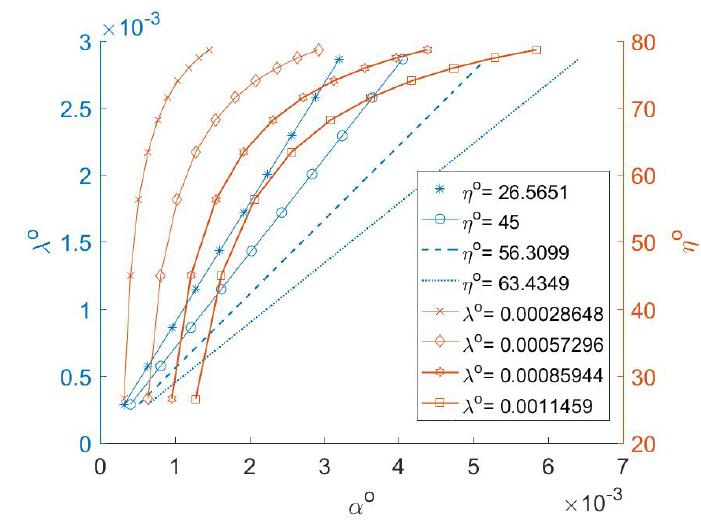
Figure 4. The relation between α and each of λ (the left vertical axis) and η (the right vertical axis). These results are obtained by changing the angles λ and η and the corresponding change in α is computed at a single sampling time of one of the simulation results.